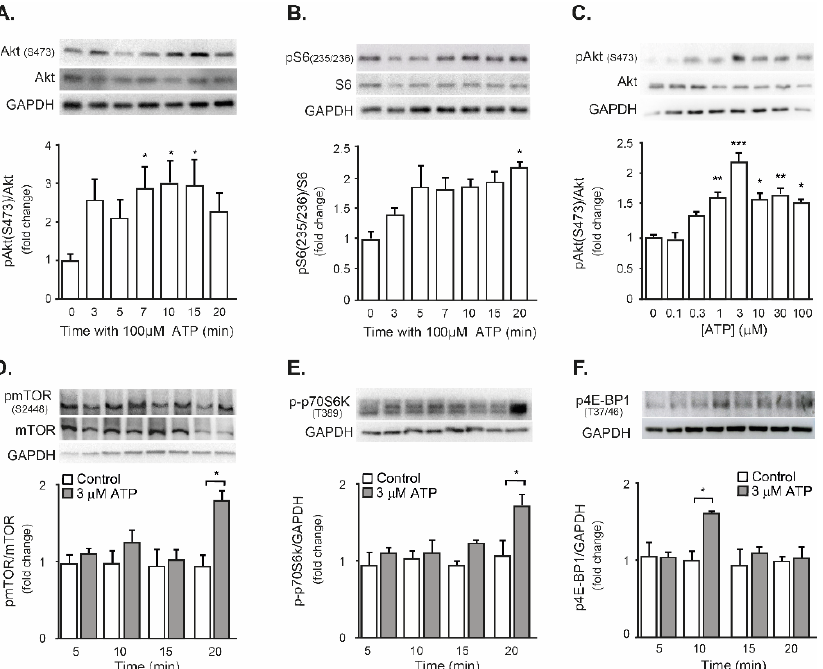
Figure 3. Exogenous ATP activated the Akt-mTOR transduction pathway in mouse FDB muscles. Kinetics of Akt phosphorylation ( A ) and S6 phosphorylation ( B ) evoked by ATP. Isolated FDB muscles were incubated with 100 µ M ATP for 0–20 min. ( C ) Exogenous ATP evoked a concentration- dependent increase in Akt phosphorylation. FDB muscles were incubated for 10 min with 0–100 µ M ATP. ( D – F ) 3 µ M ATP evoked phosphorylation of mTOR ( D ), p70S6K ( E ) and 4E-BP1 ( F ) in isolated FDB muscles. Proteins from whole muscle extracts were resolved by SDS/PAGE (upper panels in each figure). Graphs in the bottom panels correspond to densitometric quantitation of 3–4 independent experiments (mean ± SEM), expressed as relative protein levels of phosphorylated proteins to the non-phosphorylated form ( A – D ) or GAPDH ( E , F ). * p < 0.05; ** p < 0.01, *** p < 0.001. Kruskal–Wallis test followed by Bonferroni post hoc, comparing each stimulation against the 0 ( A – C ). Mann–Whitney test, control vs ATP for each time ( D – F